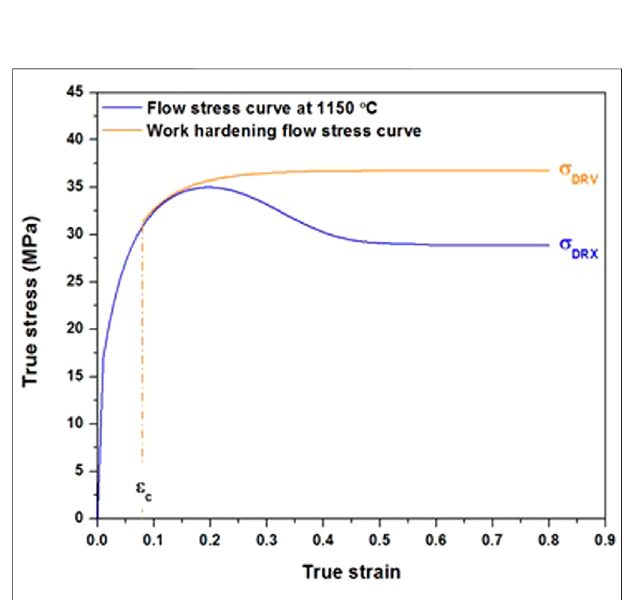
FIGURE 7 | Calculated recovery curve superimposed with experimental